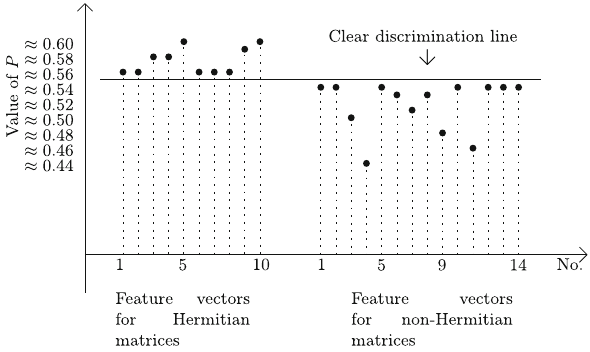
Fig.5 DiscriminationlineforvaluesofprobabilityfortheSVMmethod when matrices are encoded with feature vectors